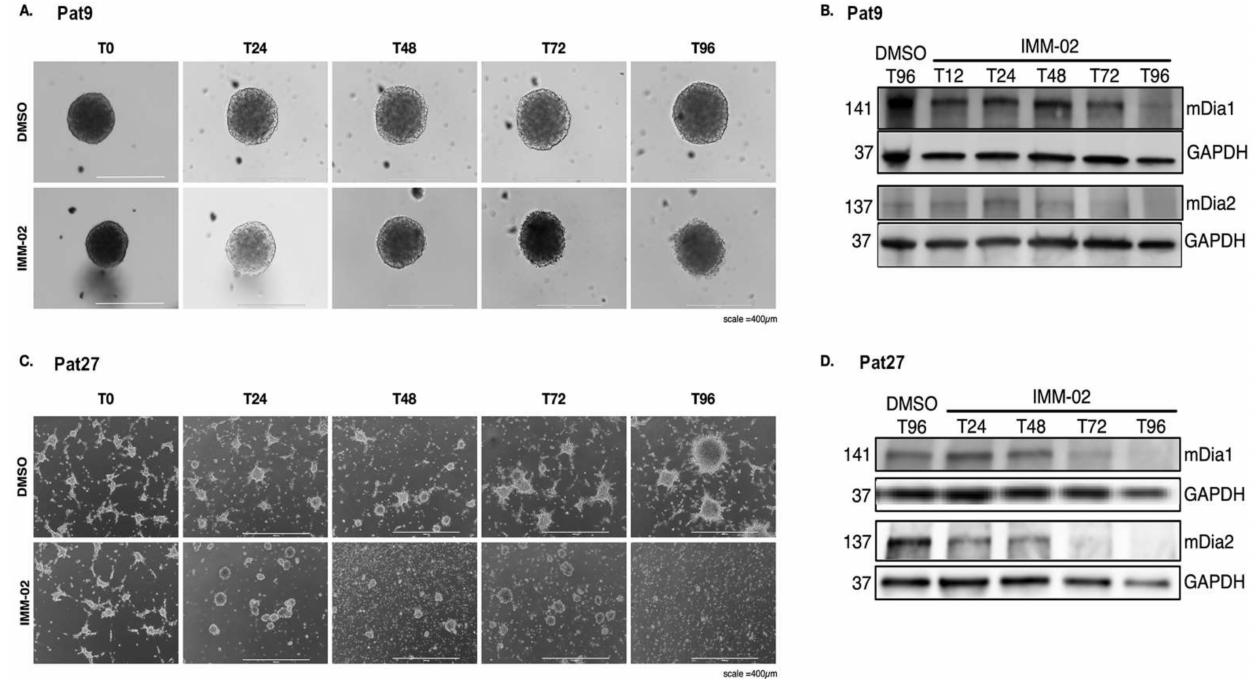
Figure 1. Pharmacological mDia agonism dynamically affects its expression and is accompanied by loss of GBM patient-derived sphere and tumor microtube integrity. ( A ) 10X phase-contrast images of free-floating Pat9 3D spheroids at indicated timepoints (in hours) maintained in DMSO (top) or 50 µ M IMM-02 (bottom). Scale bars = 400 µ m. ( B ) Western blots of cell lysates from free-floating Pat9 3D spheroids treated with DMSO or 50 µ M IMM-02 at indicated time points (in h). Molecular weight markers (kDa) are listed on left. Blotting antibodies are listed on right of blot. ( C ) 4X phase-contrast images of Pat27 2.5D cultures at indicated time points maintained in DMSO (top) or 50 µ M IMM-02 (bottom). Scale bars = 1000 µ m. ( D ) Western blots of cell lysates from 2.5D Pat27 cultures treated with DMSO or 50 µ M IMM-02 at indicated